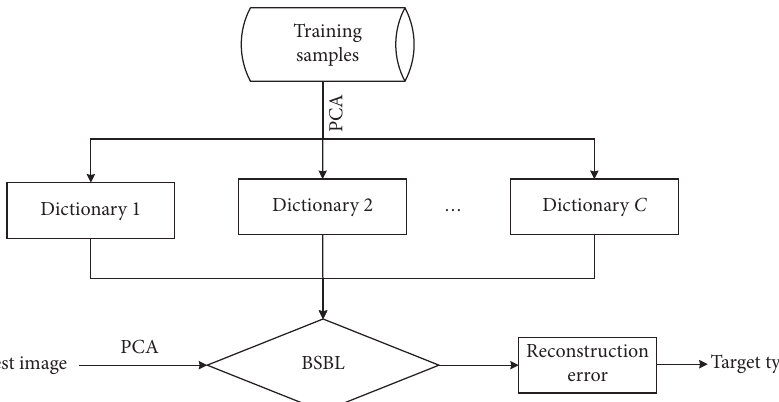
Figure 2: Procedure of SAR target recognition based on BSBL over local dictionaries.